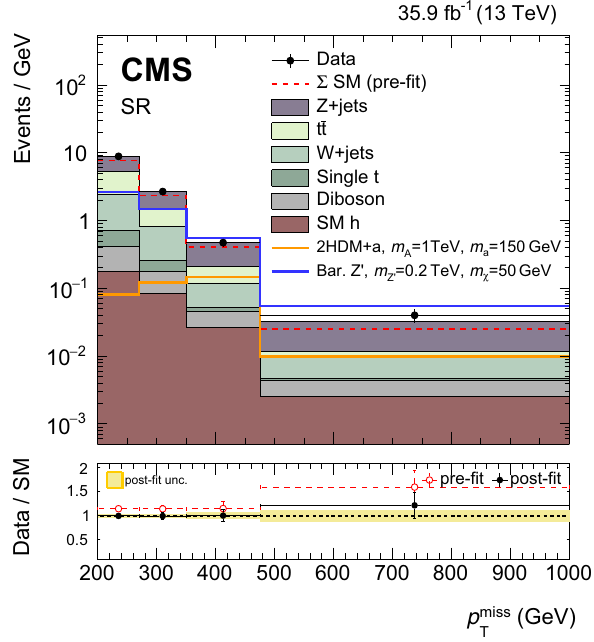
Fig. 3 The p miss distribution in the signal region before and after a T likelihood fit. The data are in agreement with post-fit background pre- dictions for the SM backgrounds, and no significant excess is observed. The dashed red histogram corresponds to the pre-fit estimate for the SM backgrounds. The lower panel shows the ratio of the data to the predicted SM background, before and after the fit. The rightmost p miss